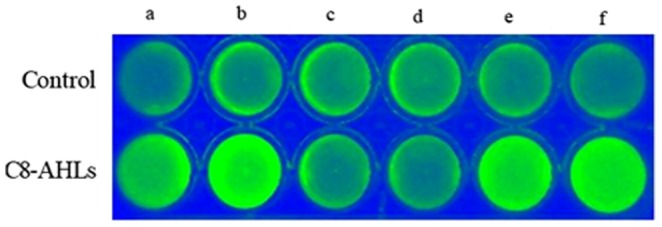
AHLs on S. Typhi BF formation.
S. Typhi, cultured in 24-well polystyrene plates for 24 h by adding 1µM C8-AHLs and 1µM saline and detected by IVIS. a,b: ST8
lux; c,d: ST8-ΔpRST98
lux; e,f: ST8-c-pRST98
lux.